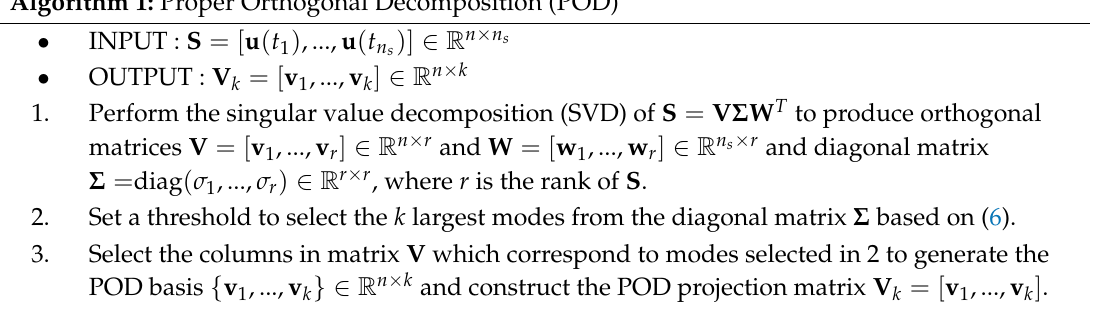
Algorithm 1: Proper Orthogonal Decomposition